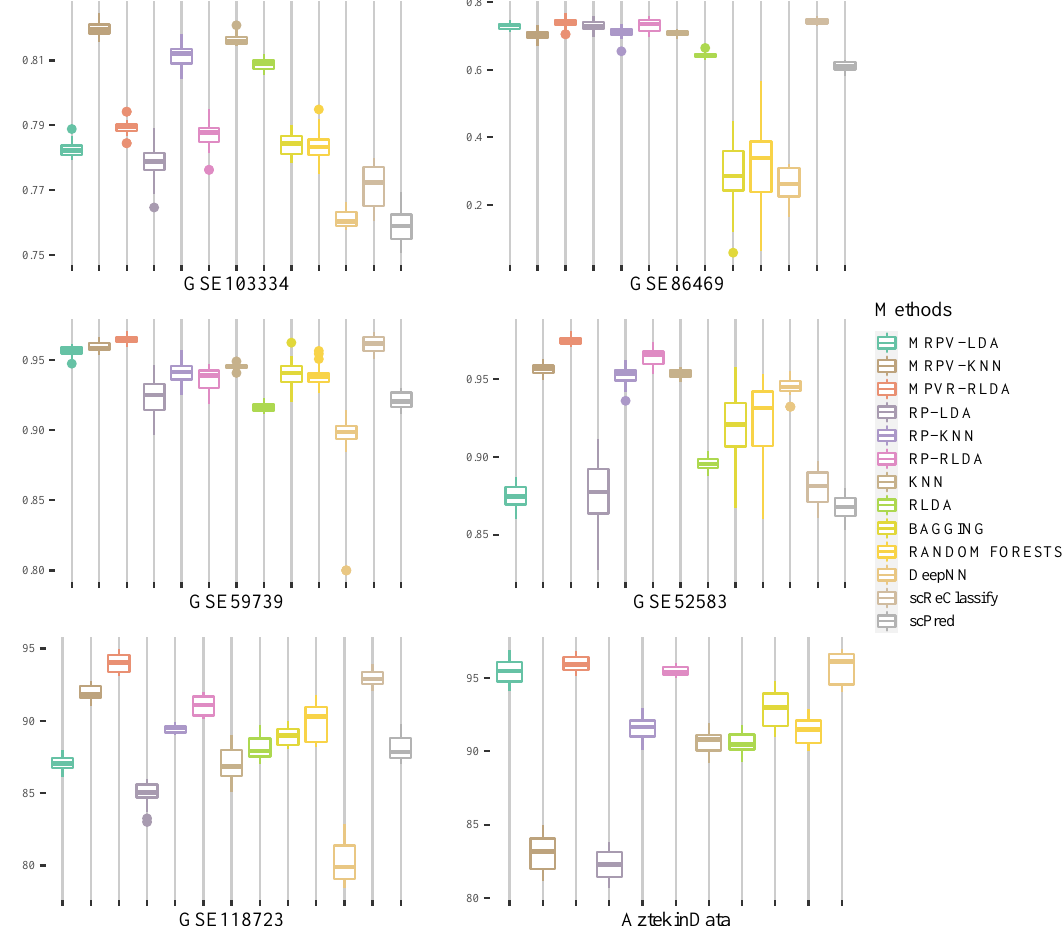
Figure 4. Classification performance of the proposed MRPV framework (MRPV-LDA, MRPV-KNN, MRPV-RLDA) compared to other ten classification methods for the datasets GSE103334, GSE86469, GSE59739, GSE52583, GSE118723, and AztekinData. Evaluation testing is made by examining Specificity. Boxplots imprint the values via 100 independent executions for each